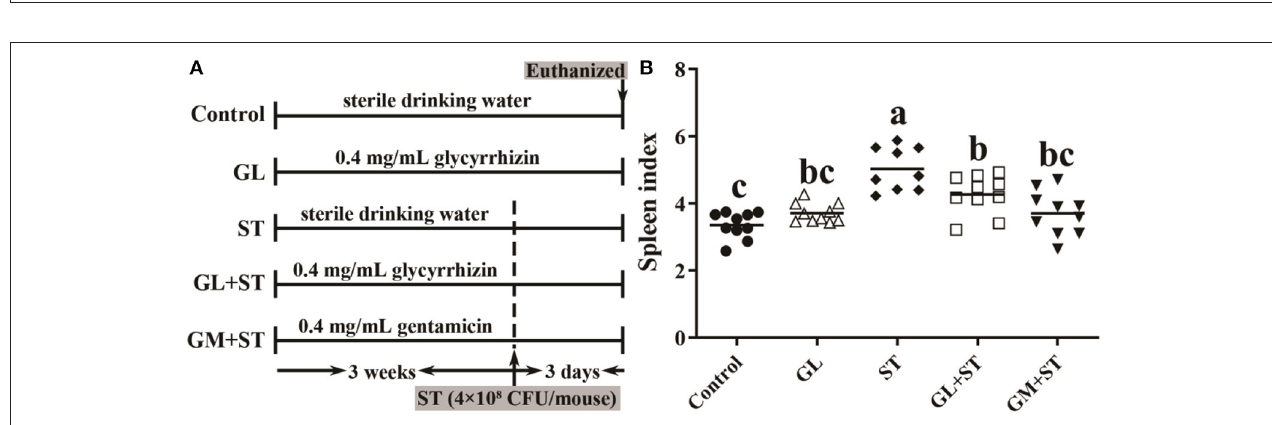
FIGURE 1 | Effect of GL on jejunum morphology in ST-infected mice. Representative images of the jejunum stained with H&E. Results are presented as mean ± SD ( n = 5/group). Different lowercase letters indicate a significant difference ( P < 0.05).